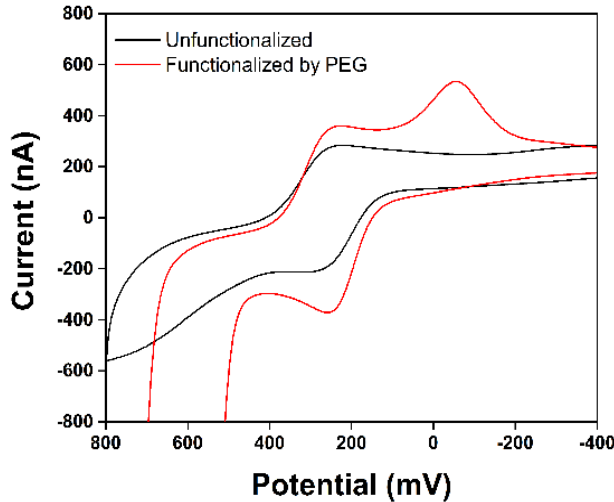
Figure 3. Red line—CV for FCA with the PEG functionalized polymer coating. Black line —CV for FCA with the unfunctionalized